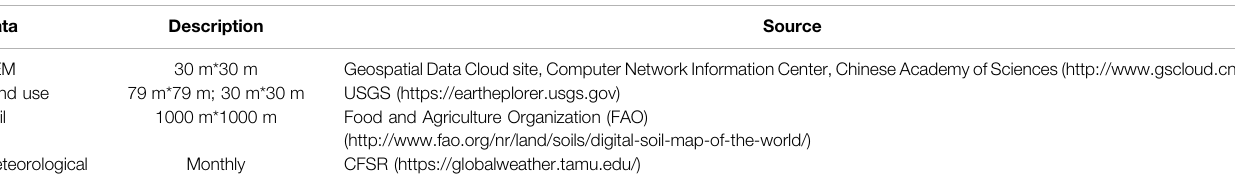
TABLE 1 | Data source and description.